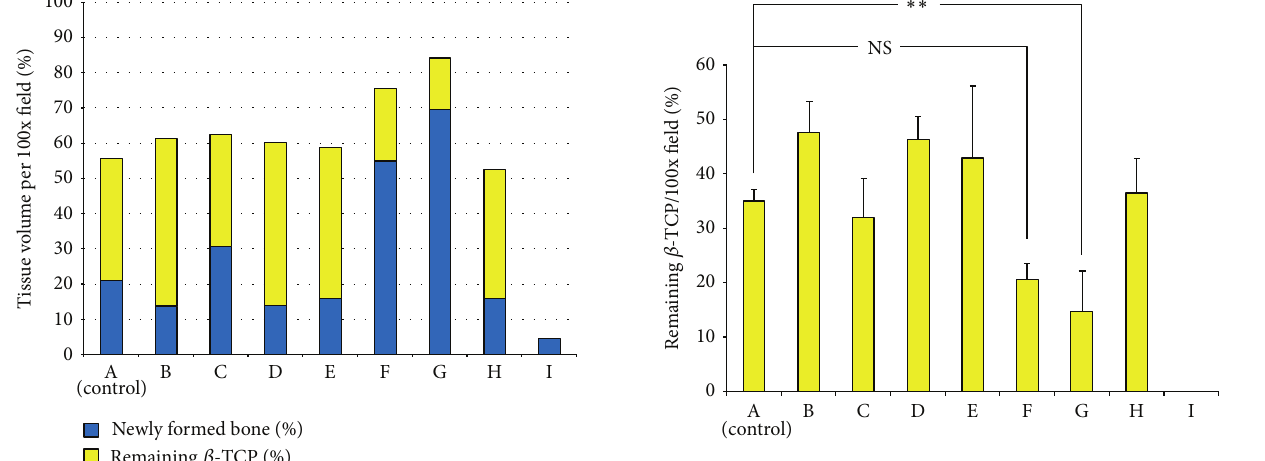
Figure 7: Percentage of remaining 𝛽 -TCP in the high magnification field. Values are shown as mean ± SD ( ∗∗ 𝑃 < 0.05 ). The percentage in group G (5 𝜇 g G-CSF with gelatin hydrogel) is significantly lower compared to group A. This result highlights the biodegradable properties of 𝛽